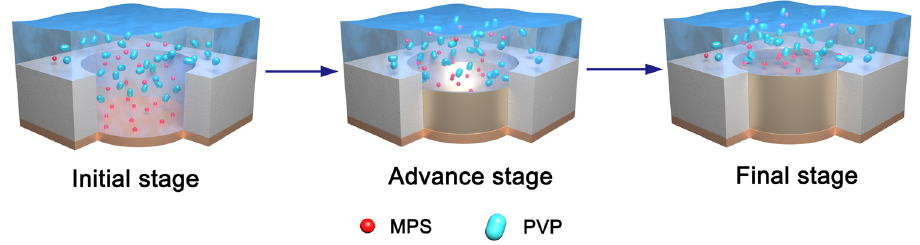
Figure 5: The strategy of three stages for the pillar electrodeposition in solution with MPS and PVP.